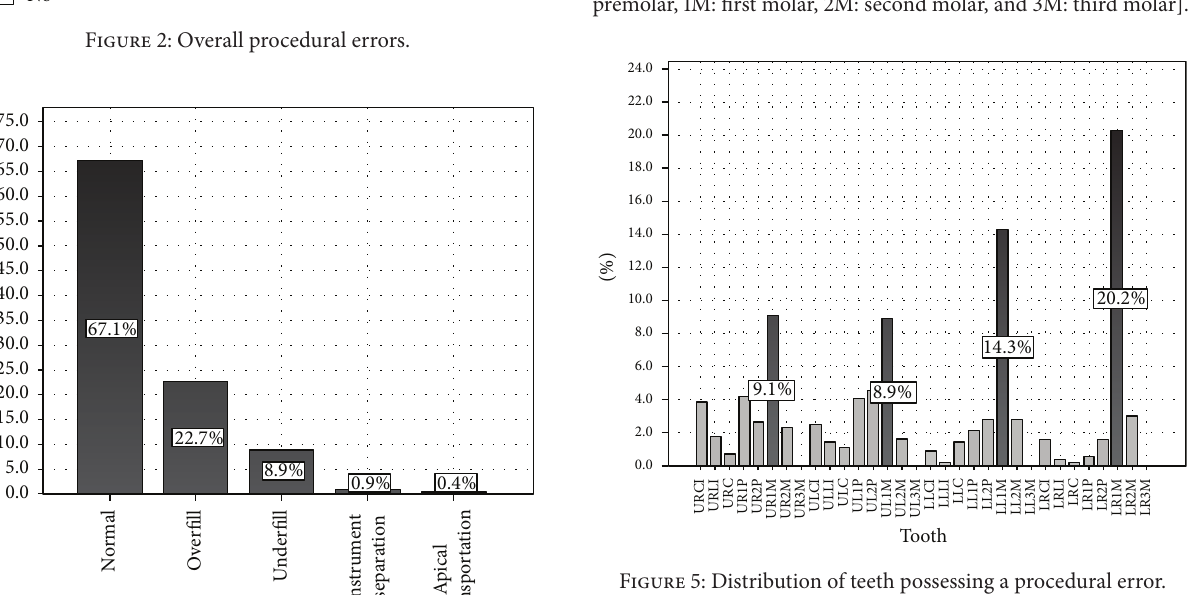
Figure 5: Distribution of teeth possessing a procedural